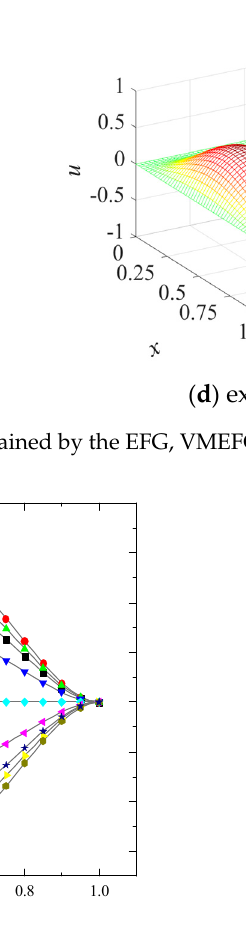
Figure 7. The snapshots of numerical solutions of the DS-GIEFG method on the lines of x = 0.1,0.2, · · · ,0.9 with 21 × 21 nodes.